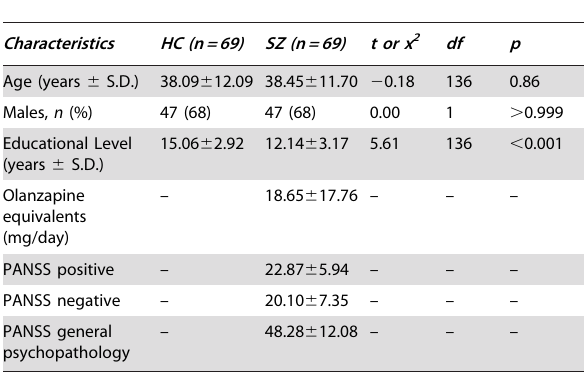
Table 1. Sociodemographic and clinical characteristics of 69 SZ and 69 HC